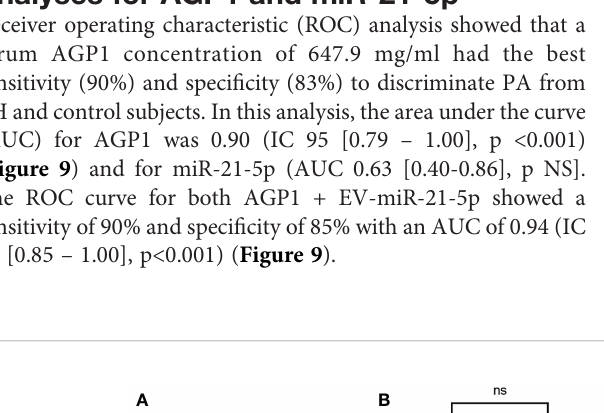
AGP1, Serum AGP1 concentration. LCN2, Serum LCN2 concentration; LCN2-MMP9, Serum LCN2-MMP9 concentration; Total LCN2, sum of free LCN2 and LCN2-MMP9 complex. Data are presented as a median and interquartile range [Q1-Q3]. Statistical analyses were performed using Kruskal-Wallis (Dunn´s) with signi fi cance p <0.05. a PA different from the EH group, b PA different from the control group, and c EH different from the control